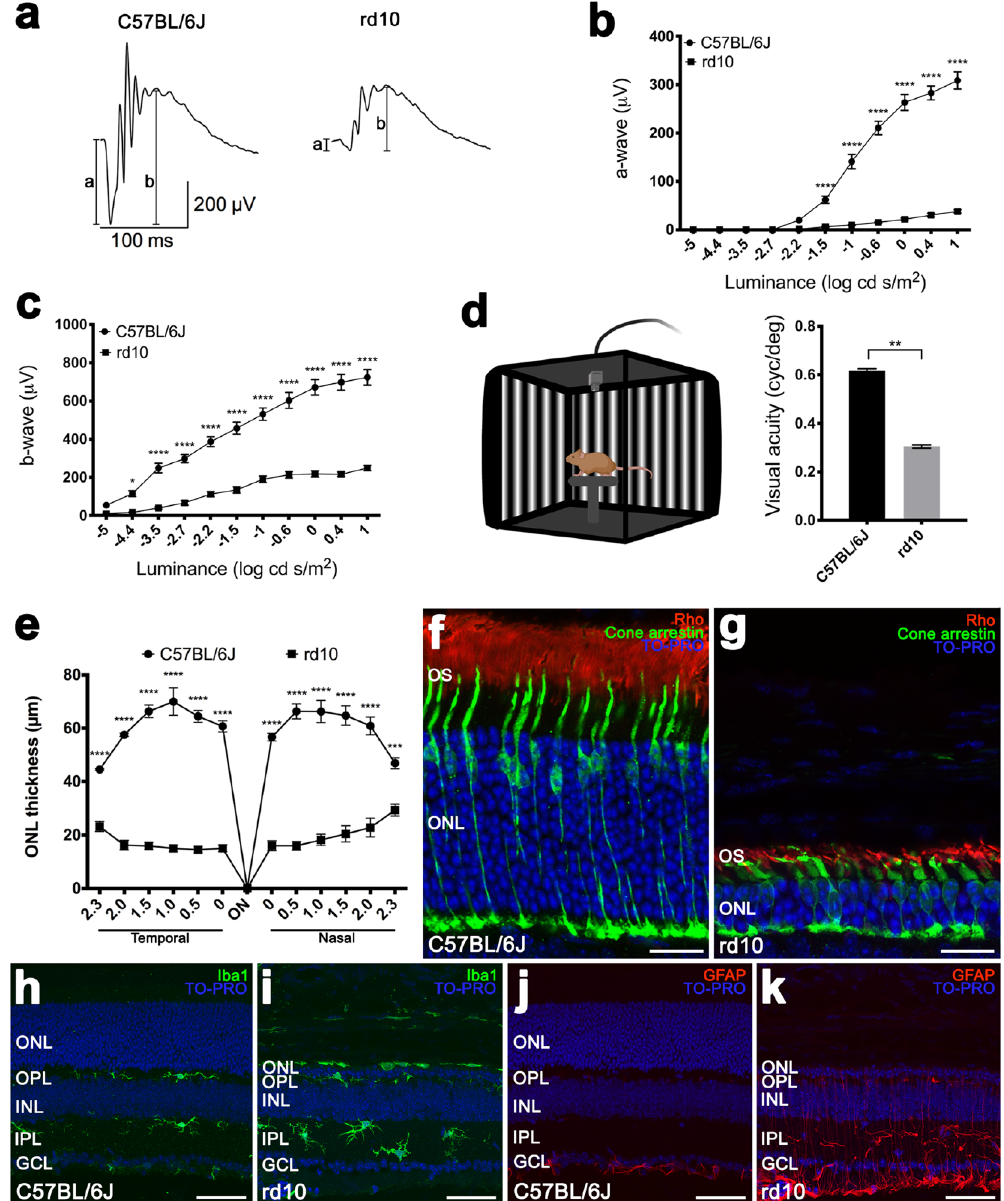
Figure 1. Retinal changes in RP mice. ( a ) Scotopic ERG responses to 1 log cd s/m 2 flashes from a normal C57BL/6J (left) and dystrophic rd10 (right) mouse. The amplitudes of both the a- and b-waves are represented. ( b, c ) Luminance-response curves for the a- ( b ) and b-( c ) waves of C57BL/6J (circles) and rd10 mice (squares). ( d ) Configuration of the optomotor system (left, image created using BioRender; https:// biore nder. com/) and visual acuity thresholds for C57BL/6J and rd10 mice (right). ( e ) Mean outer nuclear layer thickness in C57BL/6J (circles) and rd10 (squares) mice, quantified in both the temporal and the nasal side of the retina. ( f, g ) Retinal sections showing the outer retina of a C57BL/6J ( f ) and rd10 ( g ) mouse immunolabeled against cone arrestin (cone cells, in green) and rhodopsin (Rho, rod cells, in red). Nuclei were stained with TO-PRO 3 (in blue). ( h–k ) Retinal sections from a C57BL/6J ( h, j ) and rd10 ( i, k ) mouse, immunolabeled against Iba1 (microglia, in green) or GFAP (activated macroglia, in red). The cell nuclei were stained with TO-PRO 3 (in blue). ANOVA, Bonferroni’s test: * p < 0.05, ** p < 0.01, *** p < 0.001, **** p < 0.0001. ON: optic nerve, OS: outer segments, ONL: outer nuclear layer, OPL: outer plexiform layer, INL: inner nuclear layer, IPL: inner plexiform layer, GCL: ganglion cell layer. Scale bars: ( f, g ), 20 µm; ( h–k) , 50